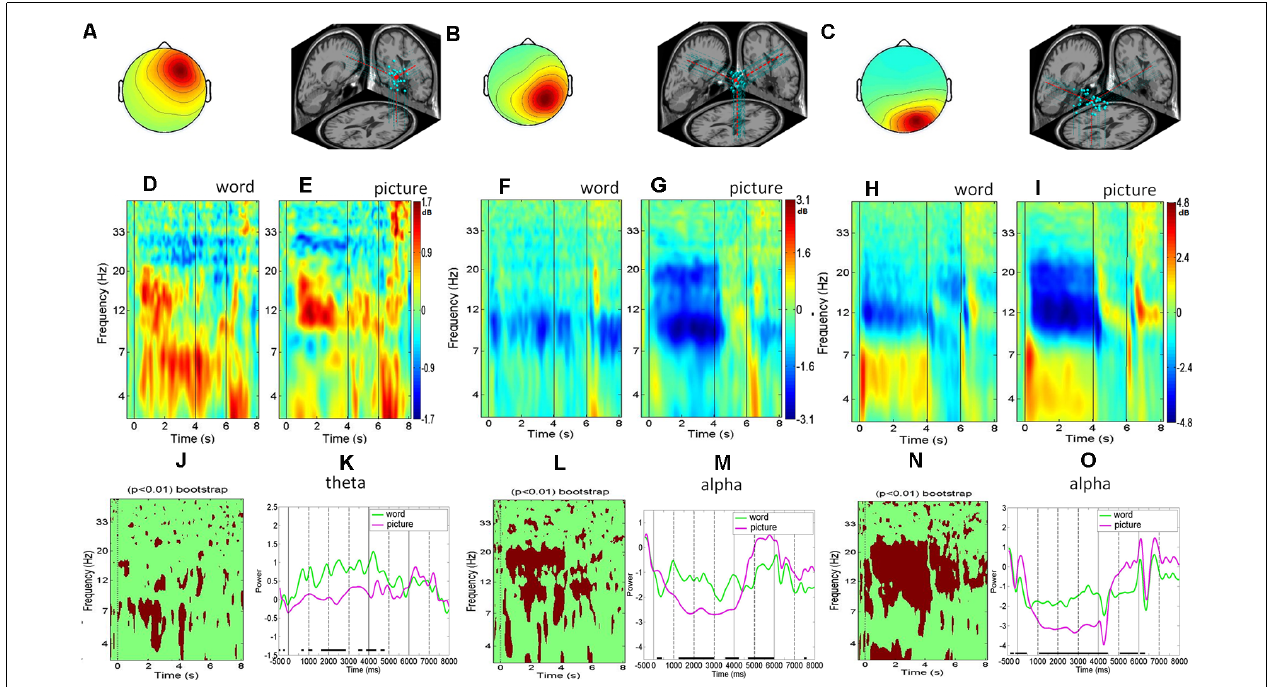
FIGURE 2 | The right frontal, right parietal, and right occipital clusters. (A–C) Scalp maps and dipole locations. (D–I) Event-related spectral perturbation analysis (ERSP’s) for word trials and picture trials. (J,L,N) The bootstrap statistics indicating significant ( p < 0.01) power changes between the word and picture conditions. (K,M,O) Mean spectral comparison between the word and picture conditions in the theta band or alpha band; green represents the mean power of word trials, purple represents the mean power of picture trial.